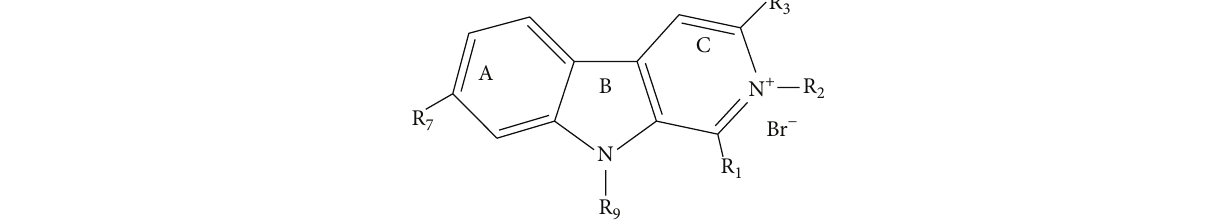
Table 3: The variables with the highest impact (positive or negative) in the final GRIND model and the structural elements of the most active ( 57 and 58 ) and inactive ( 3 and 45 ) compounds associated with these variables.